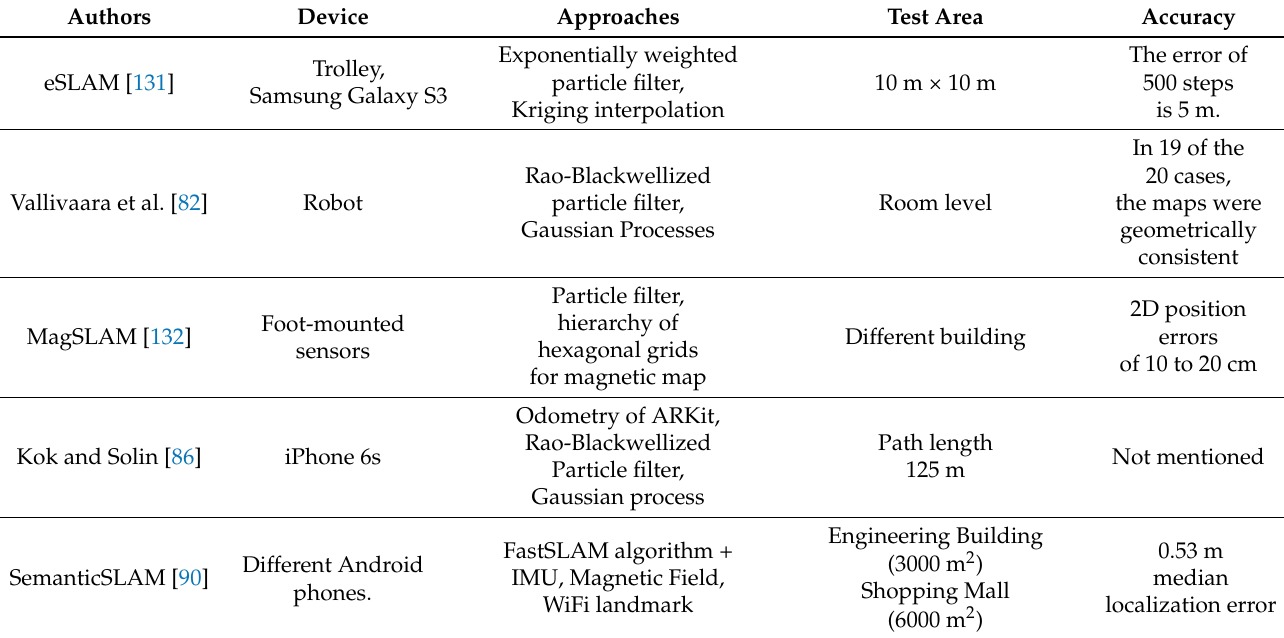
Table 5. Comparison of SLAM